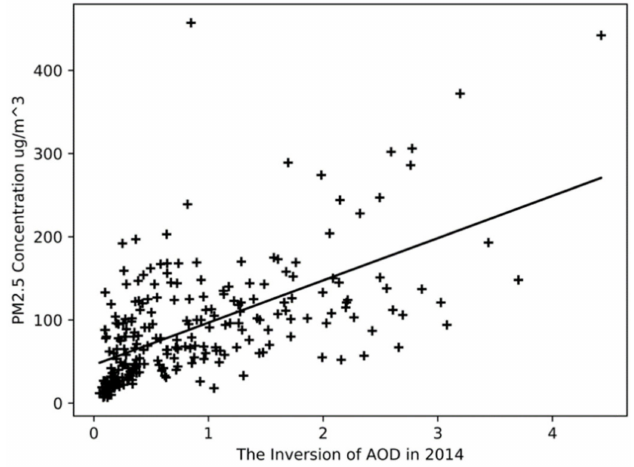
Figure 7. Overall linear regression between AOD and PM2.5 in 2014.